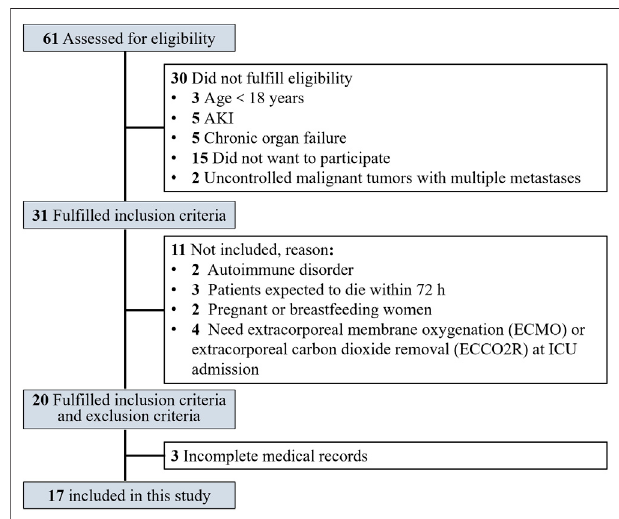
FIGURE 1 | Flowchart of study